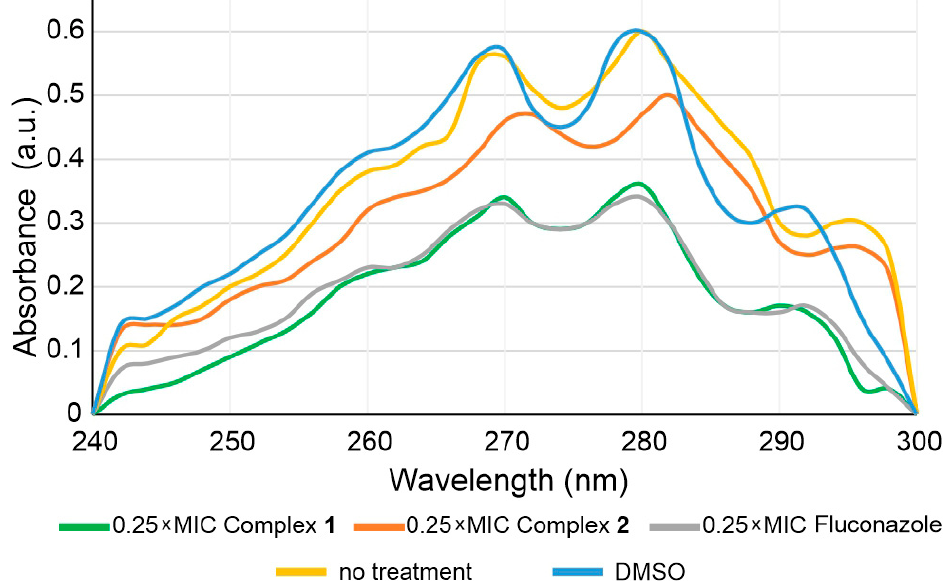
Figure 7. UV spectrophotometric ergosterol profiles between 240 nm and 300 nm of C. albicans cultures treated with 0.5 × MIC concentrations of complexes 1 and 2 and fluconazole.